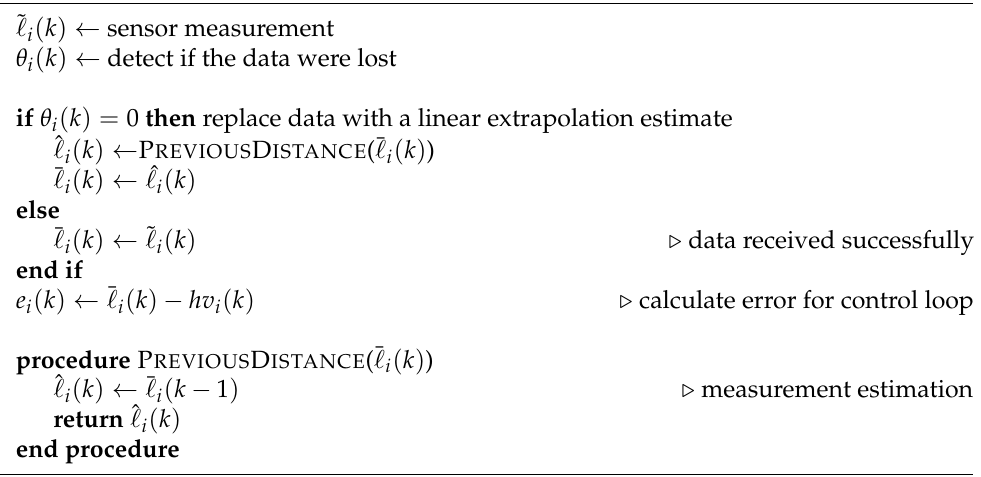
Algorithm 1 Data replacement using linear extrapolation (holding previous